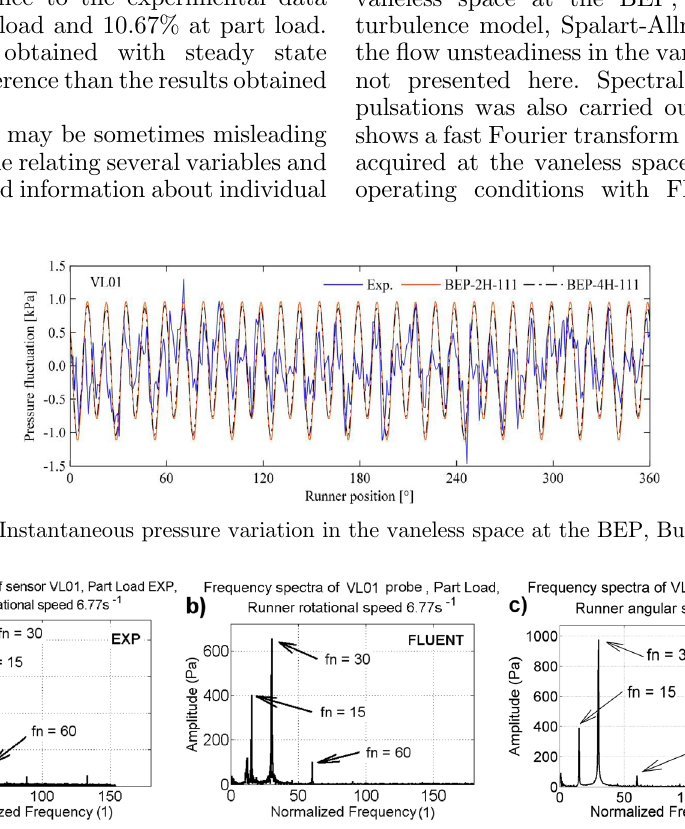
Fig. 4. Comparison of pressure amplitudes and frequencies in the vaneless space (VL01) during part load operating condition; the dimensionless frequency of 30 correspond to the blade passing frequency, Stefan